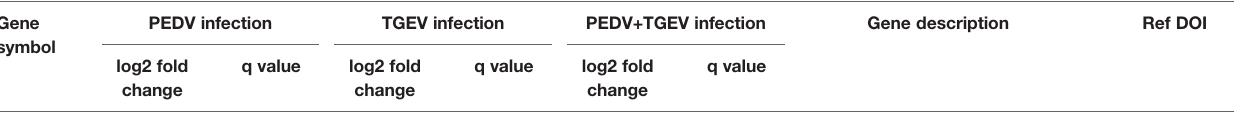
TABLE 1 | Antiviral interferon-induced genes in this